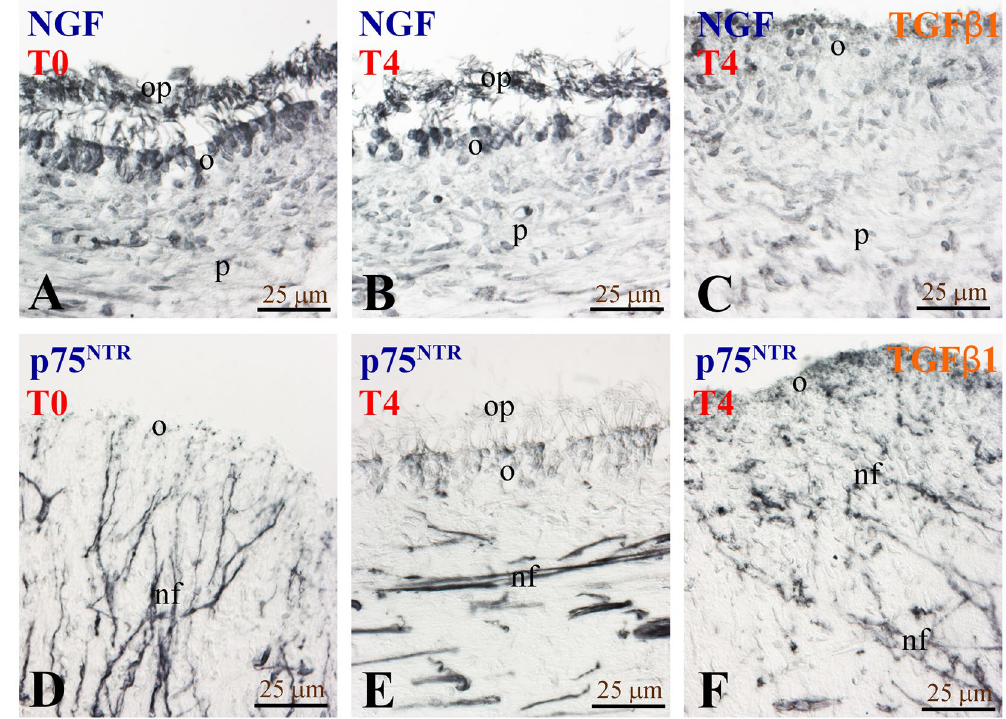
Figure 6. Effects of TGF β 1 on NGF and p75 NTR expression in cultured tooth slices in vitro . ( A ) NGF expression at T0 (starting point, time 0). ( B ) NGF expression at T4. ( C ) NGF expression at T4 upon treatment with TGF β